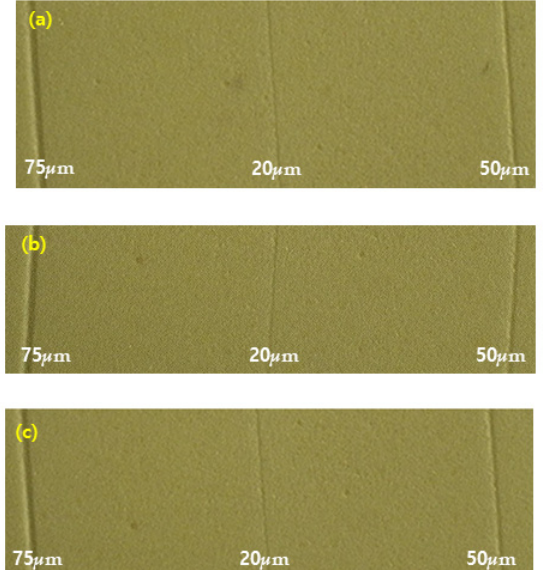
Figure 7. Detailed reproduction test of each polyvinyl siloxane impression surface: ( a ) control (non-treated) group, ( b ) nitrogen-plasma-treated group, and ( c ) air-plasma-treated group.